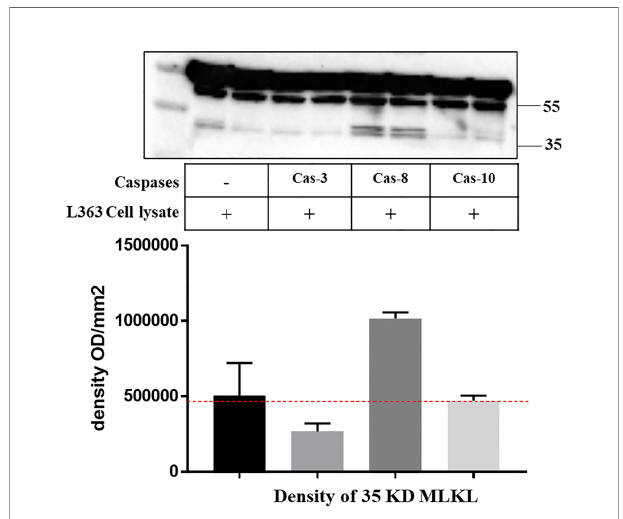
FIGURE 5 | Recombinant caspase-8 induces endogenous MLKL cleavage in L363 cell line. Cell lysate of L363 cell line was incubated with or without indicated recombinant caspases (2 U) at 37°C for 1 h. Whole cell lysates were analyzed by western blotting with an antibody that speci fi cally